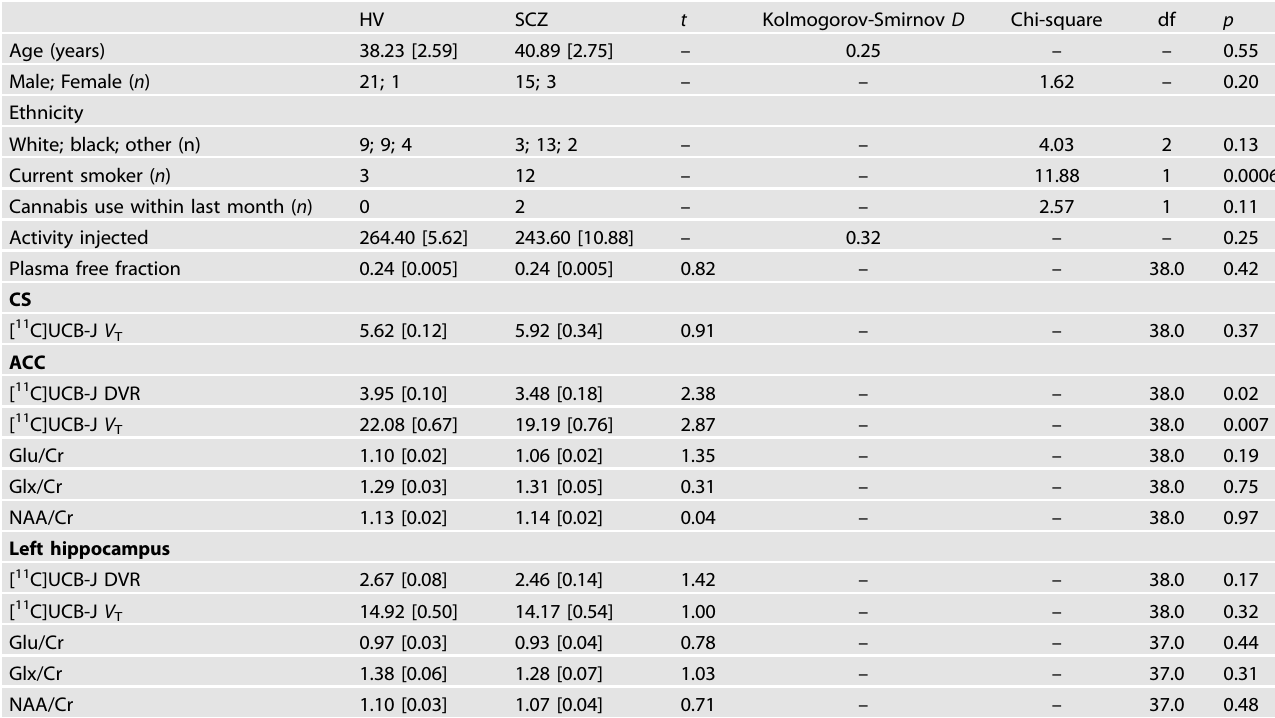
Table 1. Clinico-demographic and imaging variables in healthy volunteer (HV) and schizophrenia (SCZ) groups. Values are mean (SEM) or number ( n